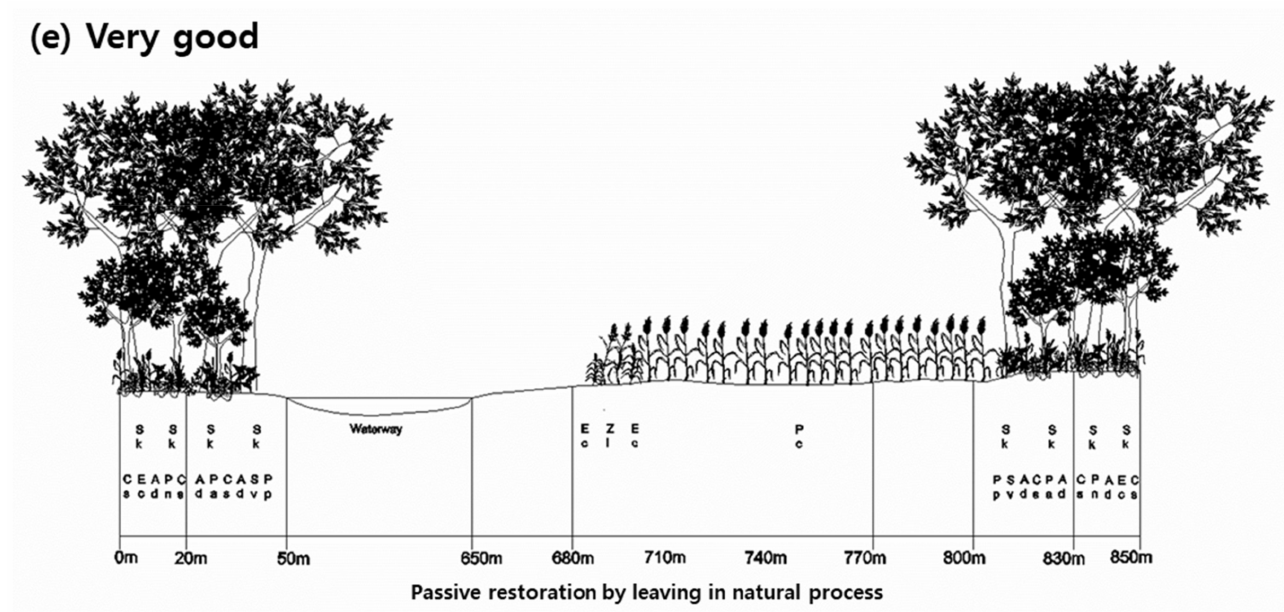
Figure 4. Ecological restoration plan prescribed based on the result of diagnostic evaluation. The lower the naturalness grade, the higher the level of restorative treatment was recommended. ‘Overall active restoration’, ‘partially active restoration’, ‘combination of active and passive restoration’, ‘artificial support’, and ‘passive restoration left in natural process’ were suggested for ‘Very poor’, ‘poor’, ‘moderate’, ‘good’, and ‘very good’ grades, respectively. It was recommended that introduction of riparian vegetation should follow reference information familiar with the reach and further, restrict on tree and shrub dominated zones and herb dominated zone where is exposed on natural disturbance such as flooding frequently, be left in natural process. Act: Acer tataricum , Ad: Ajuga decumbens , Amt: Ambrosia trifida , Ca: Clematis apiifolia , Coc: Conyza canadensis , Cs: Carex scabrifolia , Ec: Echinochloa crusgalli var. oryzicola , Fr: Fraxinus rhynchophylla , Hj: Humulus japonicus , Mb: Morus bombycis , Pa: Phalaris arundinacea , Pc: Phragmites communis , Pj: Phragmites japonica , Pm: Persicaria modosa , Pp: Persicaria perfoliata , Pt: Persicaria thunbergii , Pul: Pueraria lobata , Rj: Rhus javanica , Rp: Robinia pseudoacacia , Sg: Salix gracilistyla , Sk: Salix koreensis , Sv: Setaria viridis , Zl: Zizania latifolia. ( a ) Restoration plan of Anyang stream(H258) assessed as “very poor” in the naturalness grade. ( b ) Restoration plan of Gulji steam(H204) assessed as “poor” in the naturalness grade. ( c ) Restoration plan of Byeokgye stream(H215) assessed as “moderate” in the naturalness grade. ( d ) Restoration plan of Inbuk stream(H177) assessed as “good” in the naturalness grade. ( e ) A feature of Han River (H269) assessed as “very good” in the naturalness